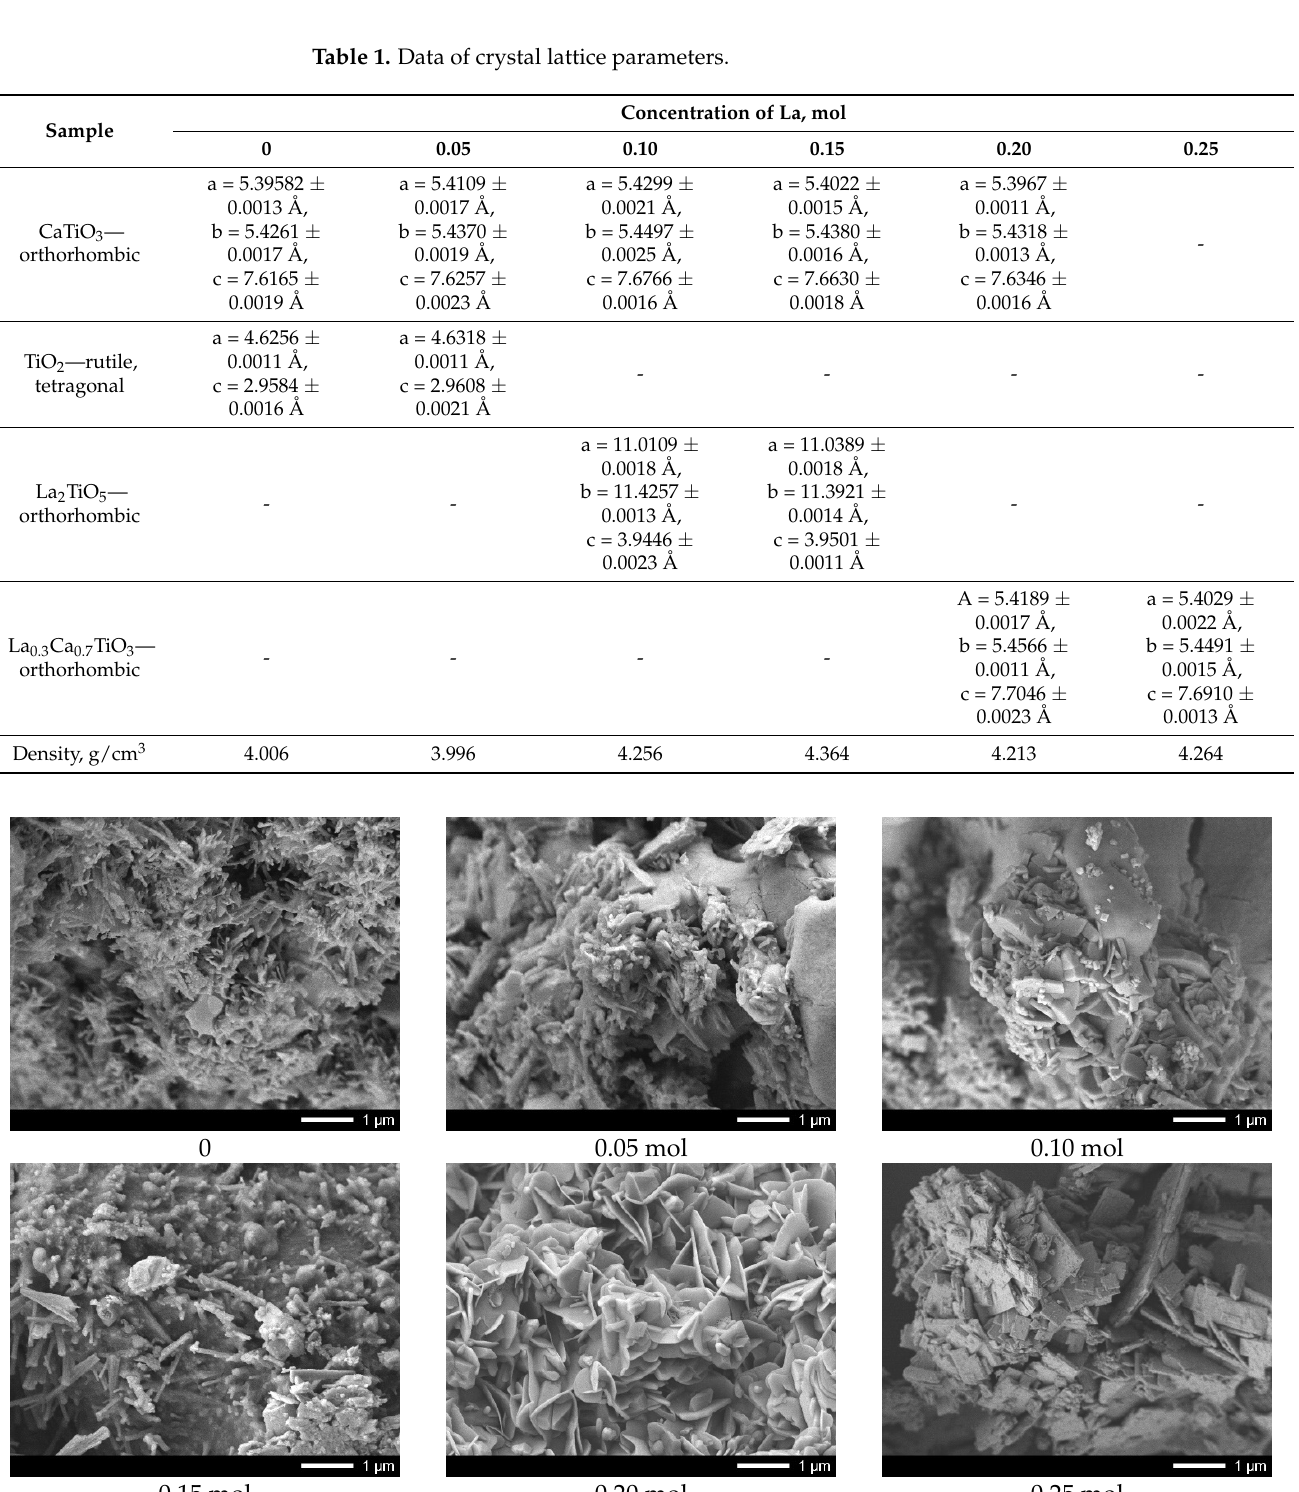
3 ceramics doped with lanthanum